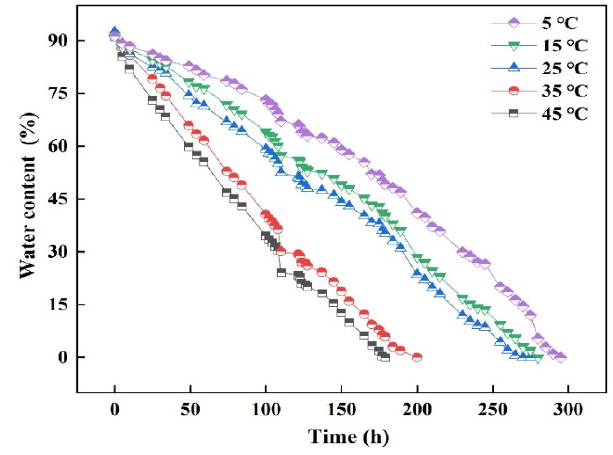
Figure 9. Water release capacity of water storage materials at different temperatures.